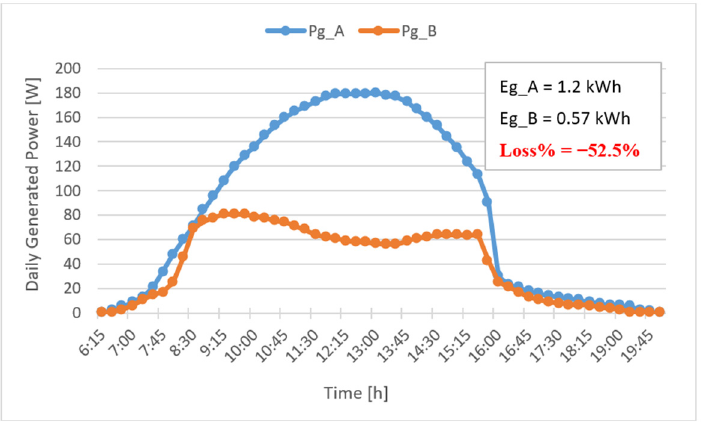
Figure 6. Daily Power generation curves, Pg_A and Pg_B, of the two prototypal PV generators A and B on a July 2021 cloudless day, together with corresponding daily generated energy values, Eg_A and Eg_B, and the percentage energy loss factor, Loss%. In this experiment, an opaque shading plywood sheet was mounted only on three PV cells of the homemade submodule of the PV generator B, and the corresponding bypass diode did not intervene.